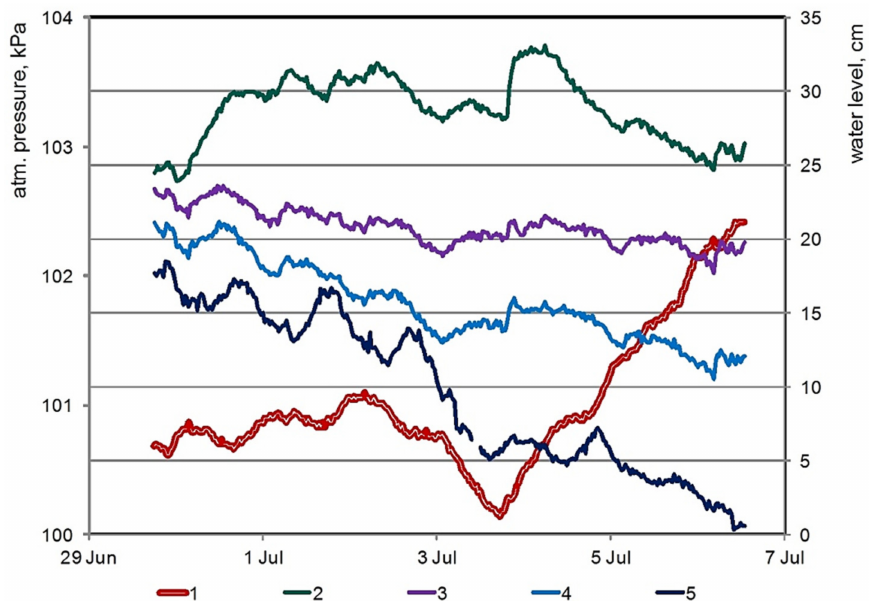
Figure 6. The WL dynamics of the suprapermafrost ground water and the surface streams under atmospheric P variations: (1) atmospheric P, (2) WL in the hillslope (pit No. 2), (3) WL in the hollow (pit No. 1), (4) WL in the Yagodny Creek (pit No. 3), and (5) WL in the Ugolnaya-Dionisiya River (outlet